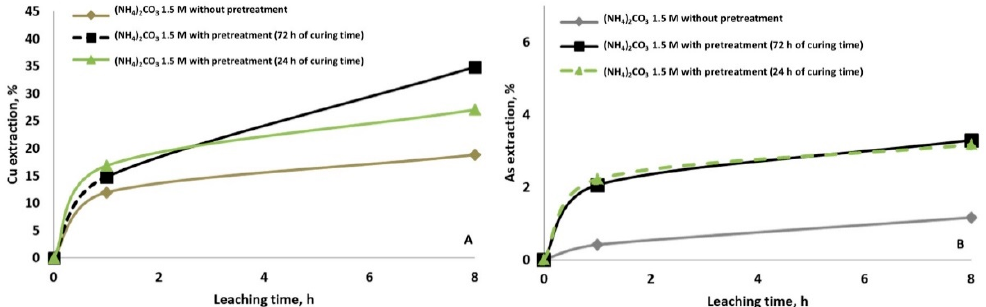
Figure 5. Copper ( A ) and arsenic ( B ) extraction at ambient condition using 1.5 M of (NH 4 ) 2 CO 3 without and with pretreatment (15 g/L of NaCl and curing time of 24 h and 72 h).